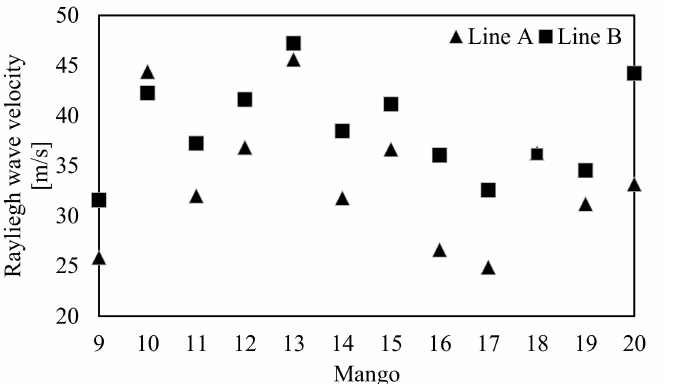
Figure 11. Rayleigh wave velocity measured around Line A and Line B of mangoes 9–20 at 0 h.